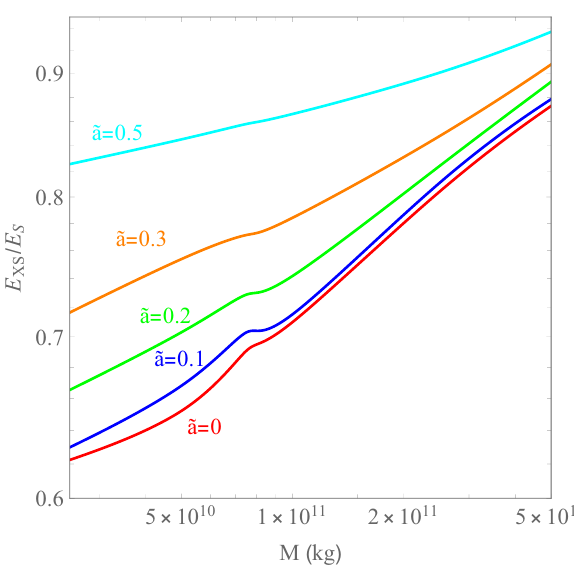
Figure 11 . Ratio E XS /E S as a function of the PBH mass computed using BlackHawk/Hazma, for a ∗ = 0 , 0 . 1 , 0 . 2 , 0 . 3 , 0 . 5 (red, blue, green, orange and cyan,